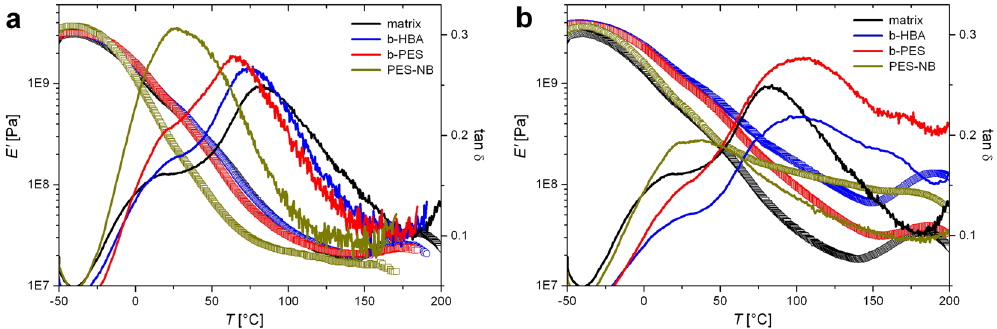
Figure 4. Storage modulus (symbols) and tan δ (lines) measured by DMA on ( a ) free films doped with PES-NB, b-HBA and b-PES in amounts matching those in free films of LDH-NC ( b ), both in comparison to a free film of the neat